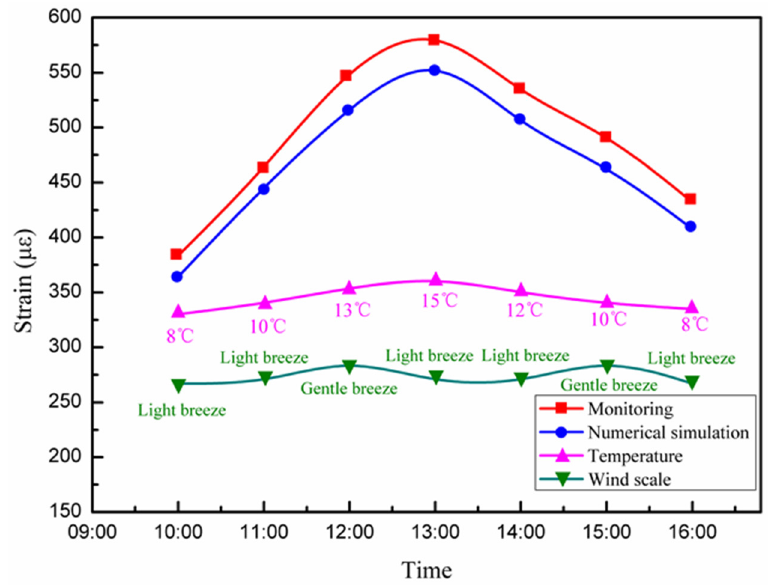
Figure 24. The changes in temperature, wind force, and strain of the long-span converter station steel structure.